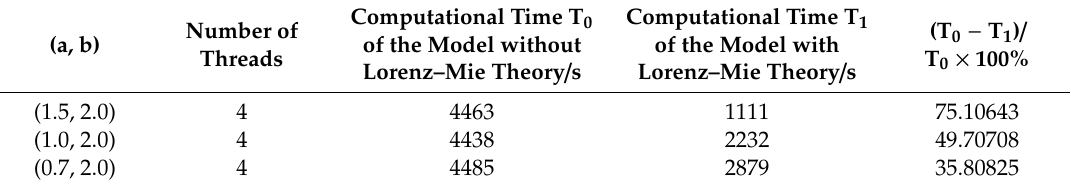
Table 4. The computational time needed for the IIM T-Matrix model with and without the Lorenz–Mie